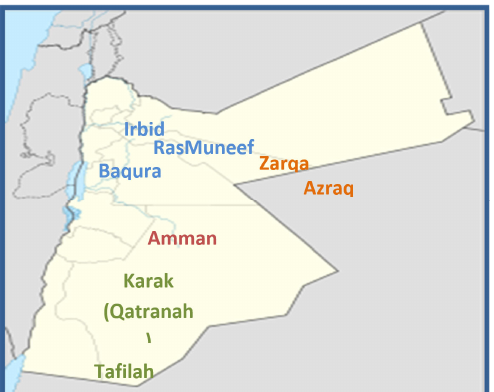
Fig. 1. Map of Jordan with each of the four regions (areas of study) shown in different colors